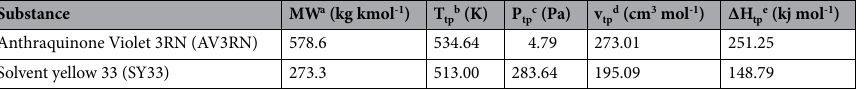
Table 2. Thermophysical properties of anthraquinone violet 3RN and solvent yellow 33 (solid solutes), required in Eq. (14). a Molecular weight. b Triple point temperature. c Triple point pressure. d Triple point volume. e Heat of fusion at the triple